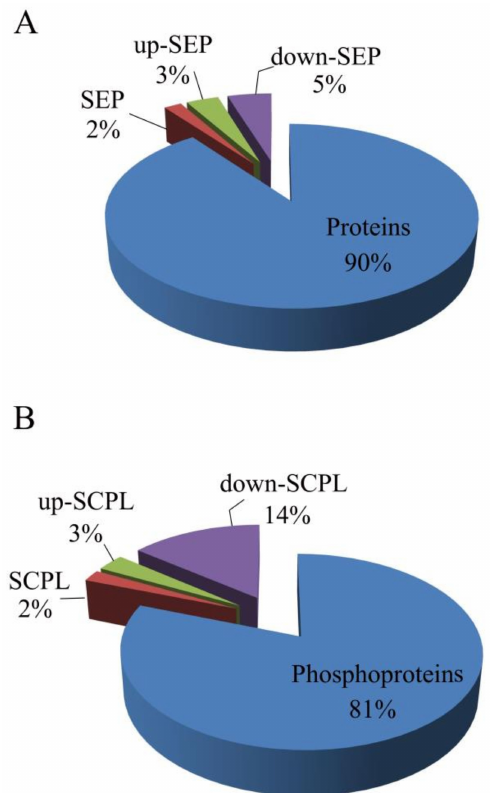
Figure 3. ( A ) Distribution of up-, mid-, and downregulated specifically expressed proteins (SEPs) in the identified proteins; ( B ) Distribution of up-, mid-, and downregulated significant changes in phosphorylation level (SCPL) proteins in the identified